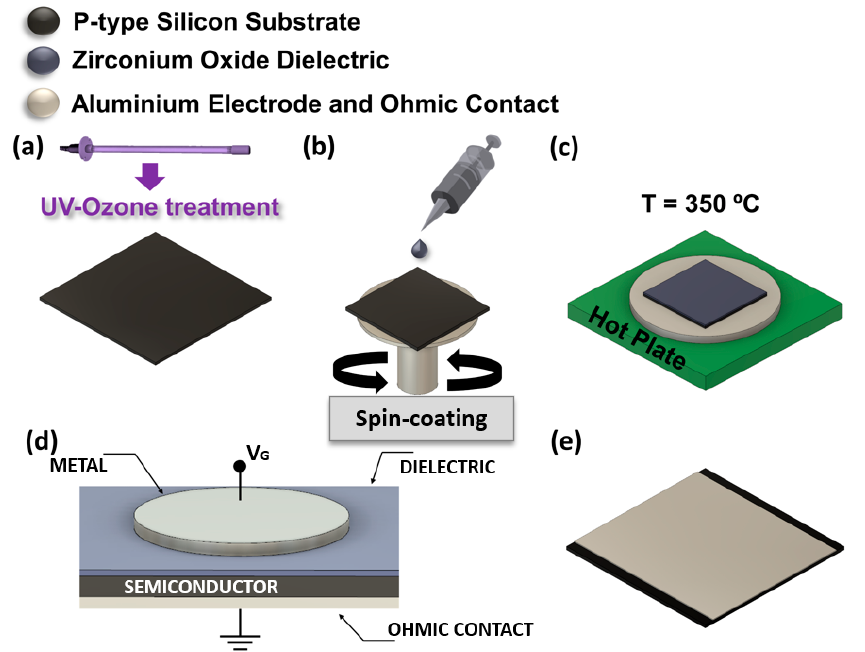
Figure 1. Steps to fabricate the MIS capacitor after the cleaning procedure: ( a ) surface treatment on silicon (Si) substrate by UV-ozone for 15 min; ( b ) deposition of the zirconium oxide precursor solution by spin coating technique; ( c ) annealing treatment of the substrate for film densification; ( d ) scheme of the device after the deposition of top electrodes (80 nm Al) by thermal evaporation; ( e ) scheme of the device after the deposition of the bottom electrode (80 nm Al) by thermal evaporation.